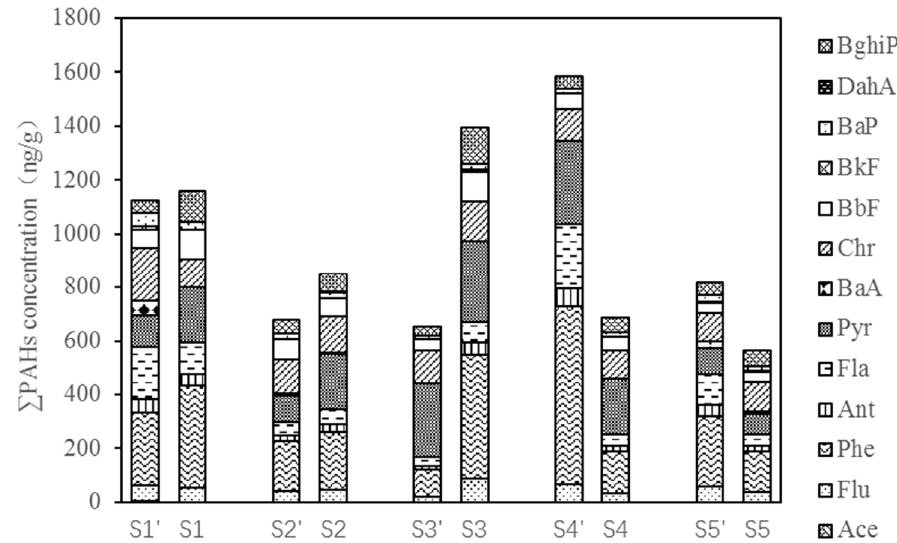
Figure 2. Distribution of 16 polycyclic aromatic hydrocarbons (PAHs) in the estuary of Hongze Lake.